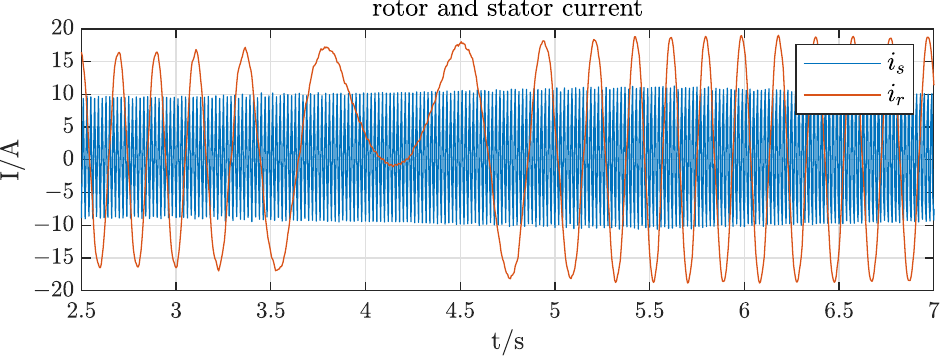
Figure 10. Change from supersynchronous speed to subsynchromous